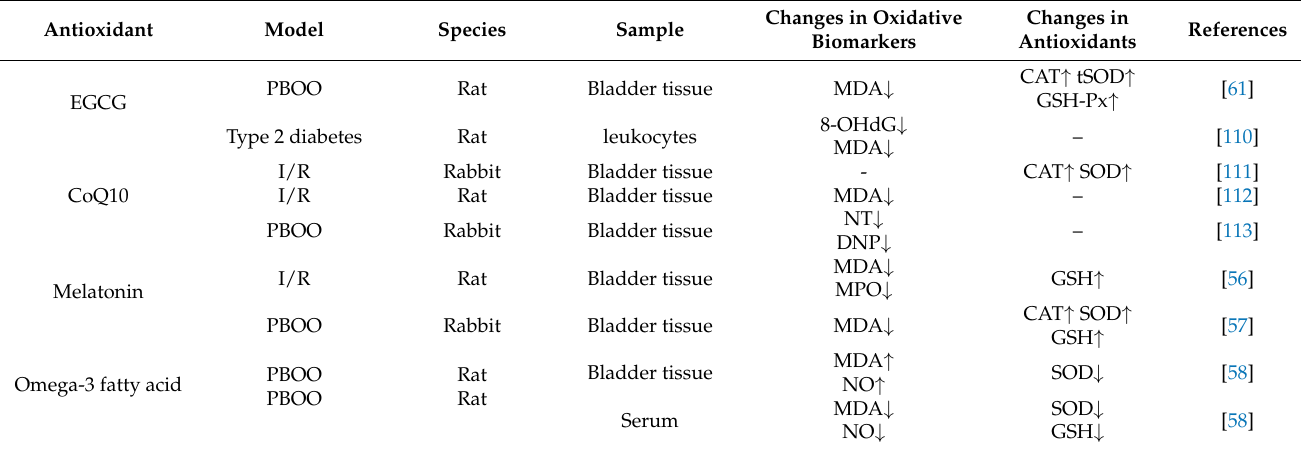
Table 2. Summary of research findings for effects of various